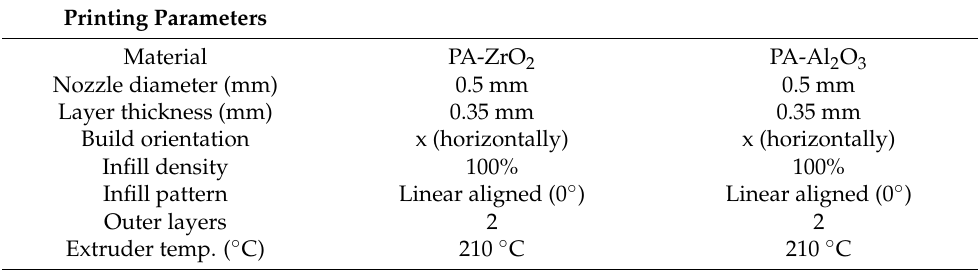
Table 3. Processing parameters of the soaking test